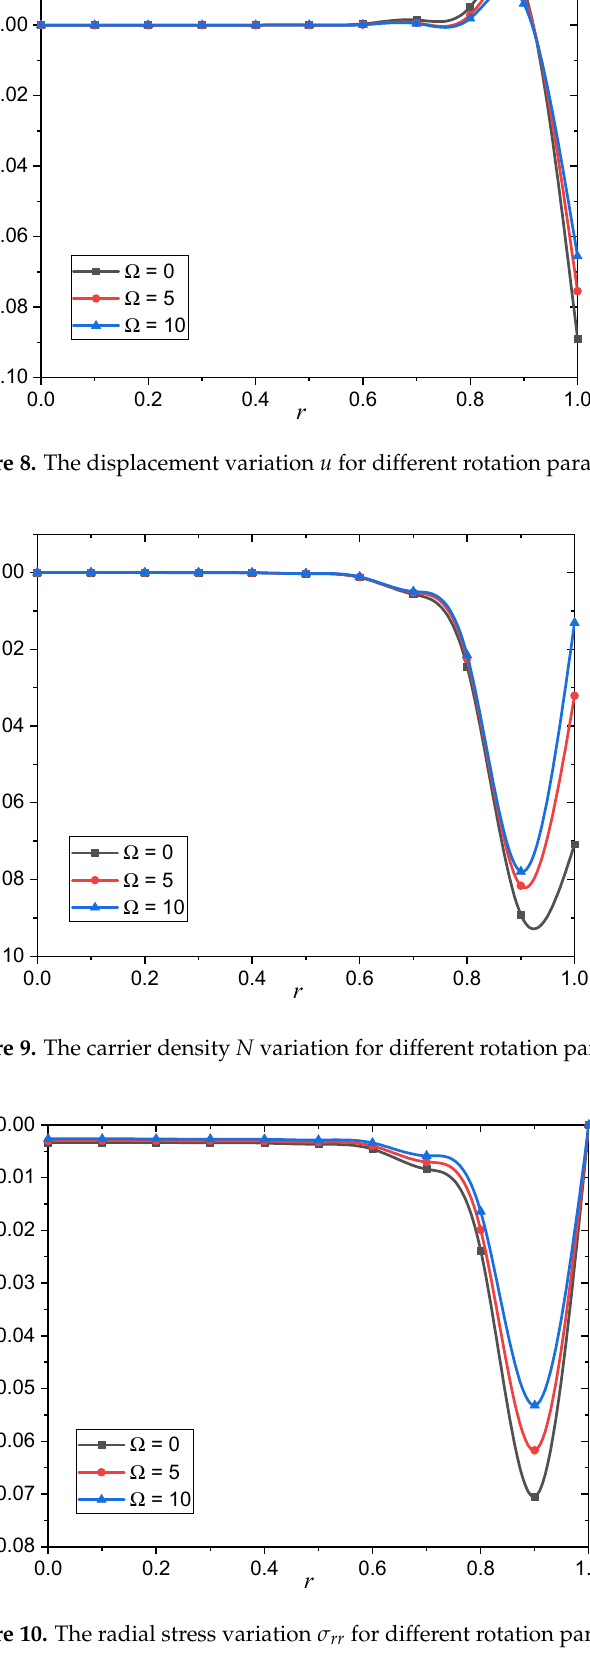
Figure 10. The radial stress variation σ rr for different rotation parameter Ω .